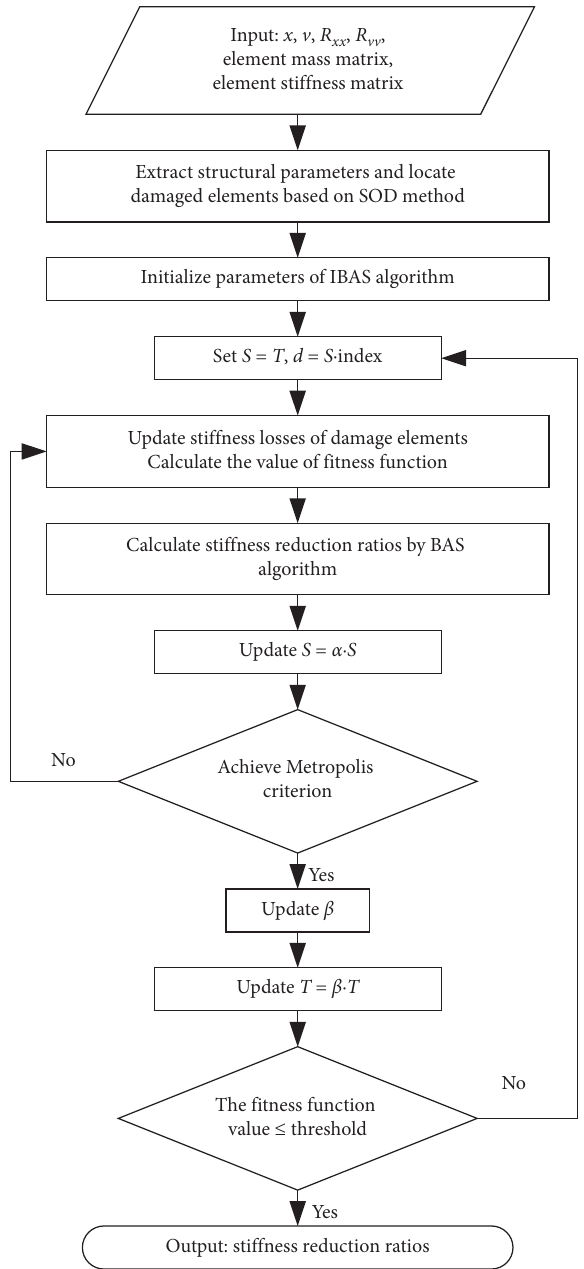
Figure 1: Schematic diagram of damage